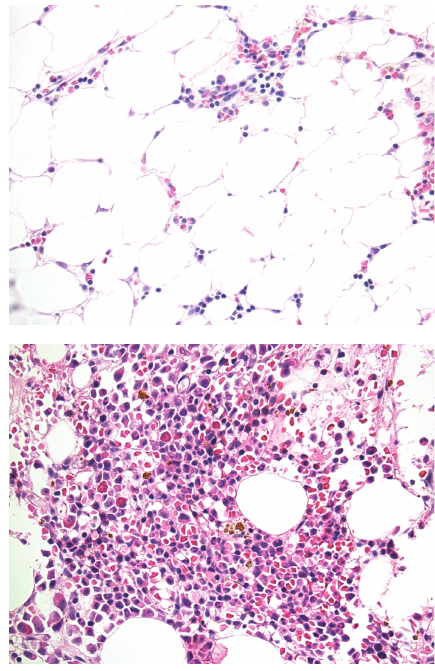
Figure 1: This figure illustrates the improvement in bone marrow biopsy findings with rituximab therapy. Pictures were taken under 40x magnification. The top figure shows the aplastic marrow on diagnosis in March 2007. The lower figure shows restoration of trilineage hematopoiesis with decreased megakaryocytes in July 2008, 6 months after the first cycle of